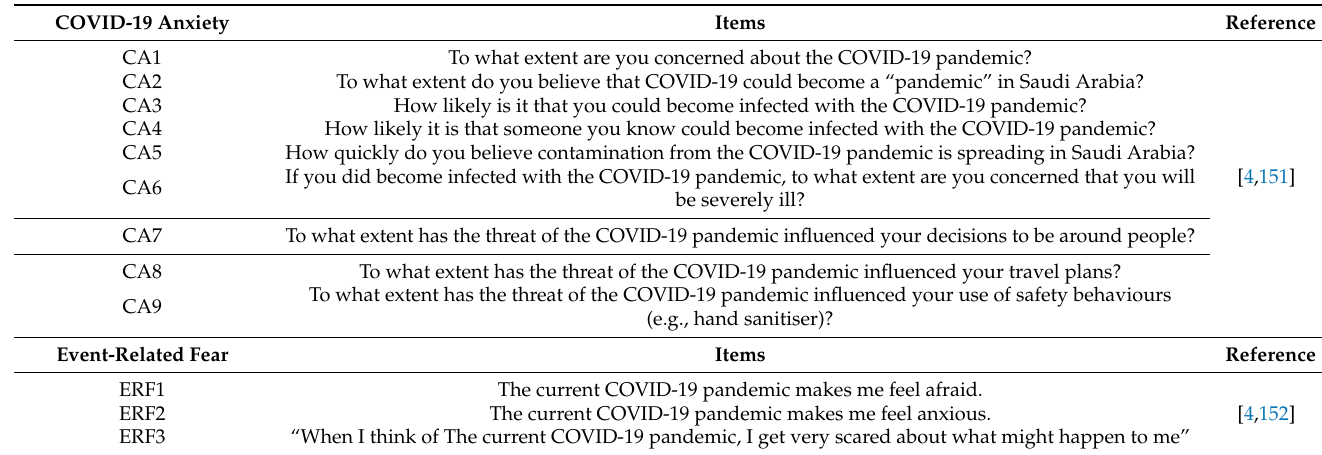
Table A1. Variables with measurement items